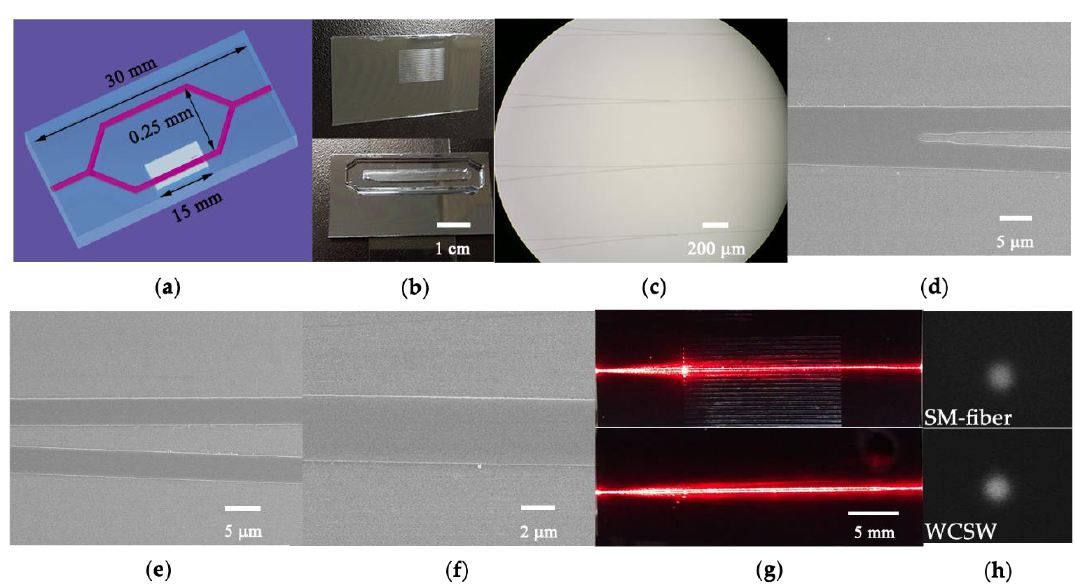
Figure 4. ( a ) Schematic diagram of the MZI sensor. ( b ) The fabricated MZI sensors before and after sealing with PDMS channel. ( c ) Photograph of S-bend splitters. ( d – f ) SEM images of S-bend, two arms and zoomed one arm of the MZI. ( g ) Light propagation when sensing arm in air (upper image) and DMSO/solutions (lower image). ( h ) Near field spots of the fiber mode and TM fundamental mode of WCSW.